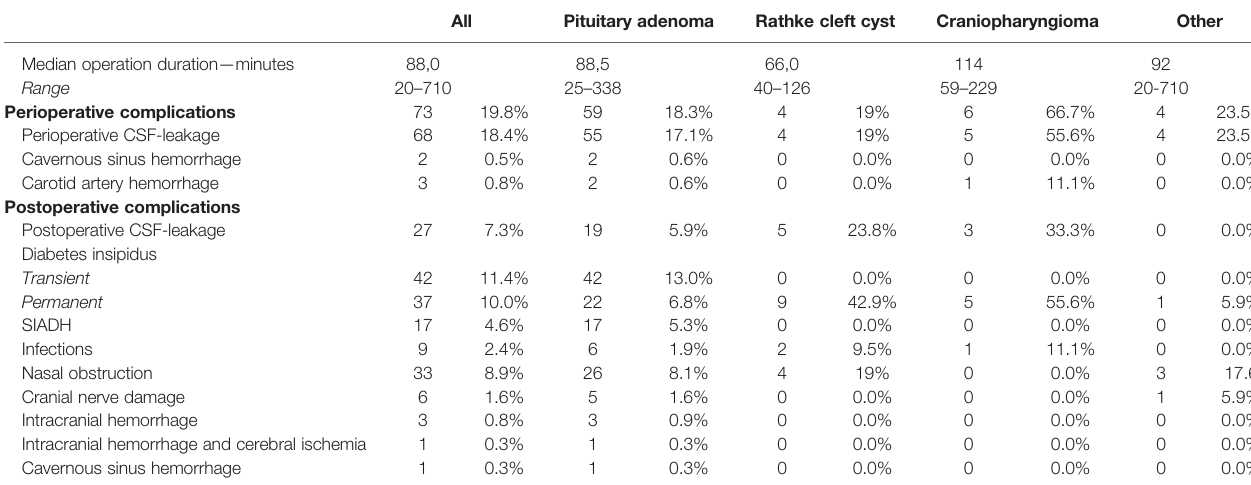
TABLE 3 | Perioperative and postoperative complications in relation to the pathology treated. All Pituitary adenoma Rathke cleft